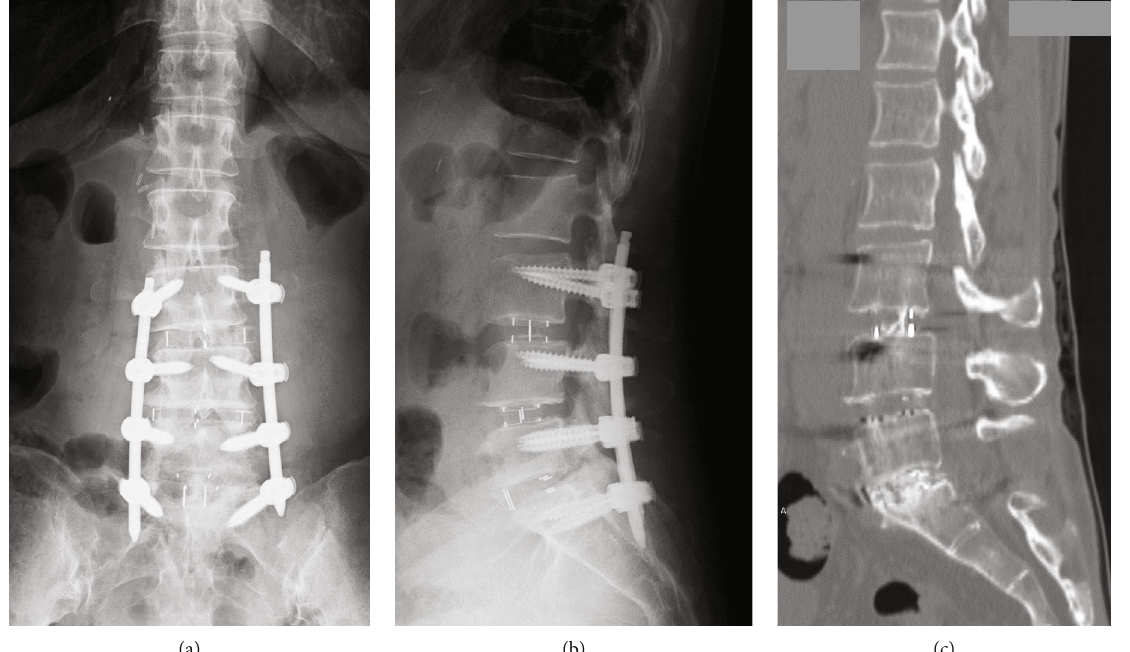
Figure 3: Postoperative radiographs and computed tomography (CT) image of the lumbar spine of a 49-year-old woman with degenerative lumbar disease. (a) anteroposterior view X-ray, (b) lateral view X-ray, and (c) sagittal CT image two years following